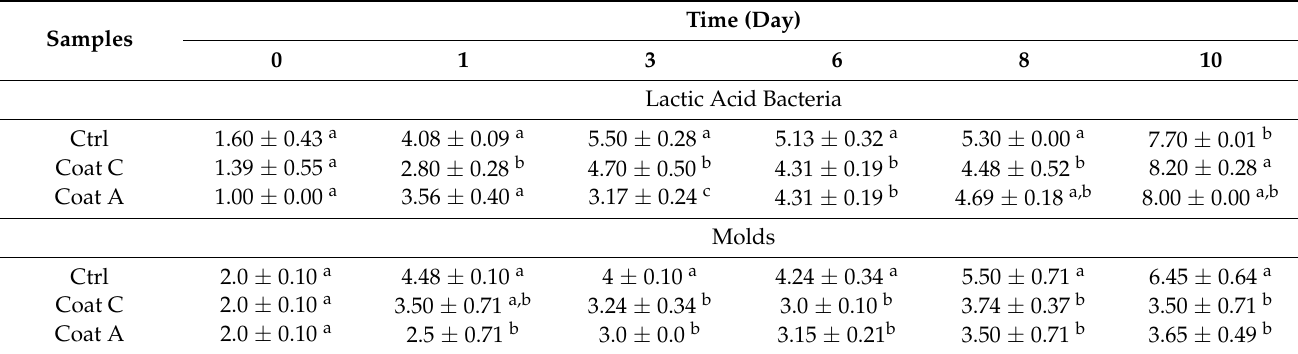
Table 2. Molds in coated and uncoated prickly pears during storage at 4 ◦